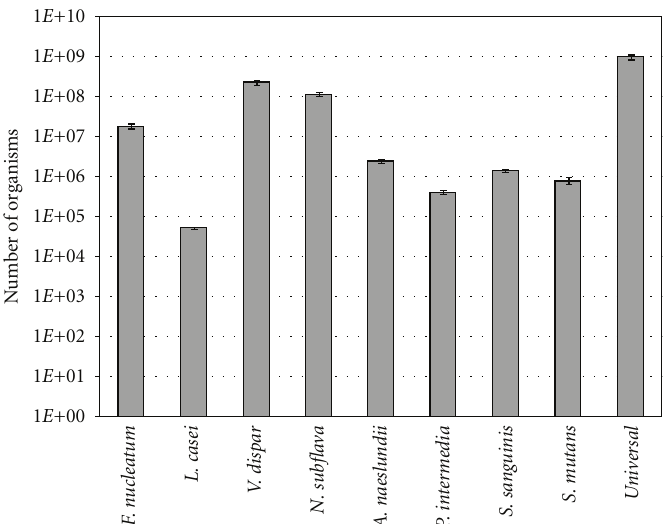
Figure 1: Numbers of each of the taxa investigated in pooled saliva. Error bars represent the standard deviation ( n = 3).